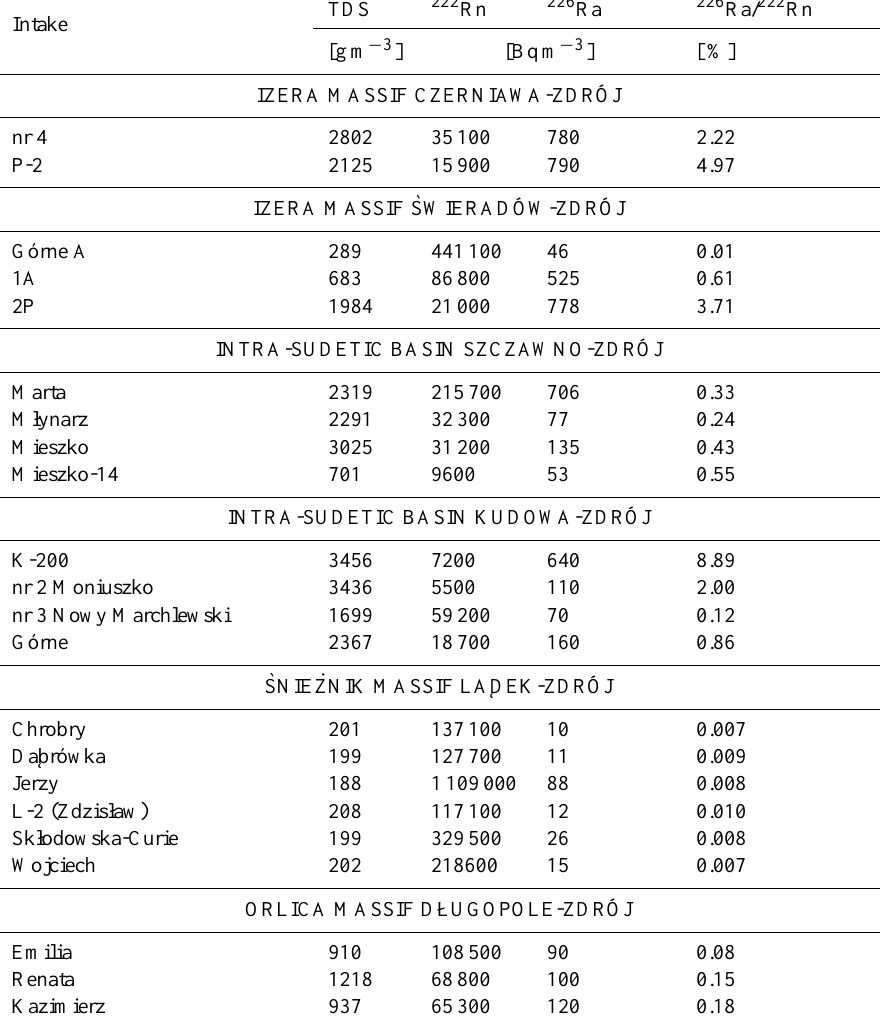
Table 3. Percentage part of 222 Rn atoms produced as a result of the decay of 226 Ra 2 + ions dissolved in groundwater in total 222 Rn atoms dissolved in groundwater of selected intakes in the Sudetes. These values are presented together with the information on 222 Rn and 226 Ra activity concentrations and TDS values for these groundwaters (according to Przylibski,